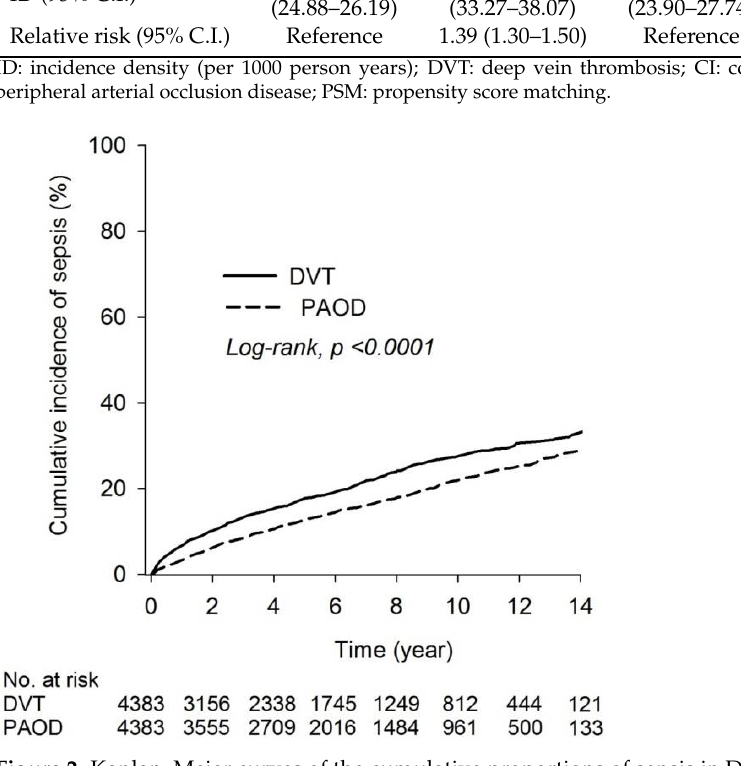
Figure 2. Kaplan–Meier curves of the cumulative proportions of sepsis in DVT and PAOD patients.